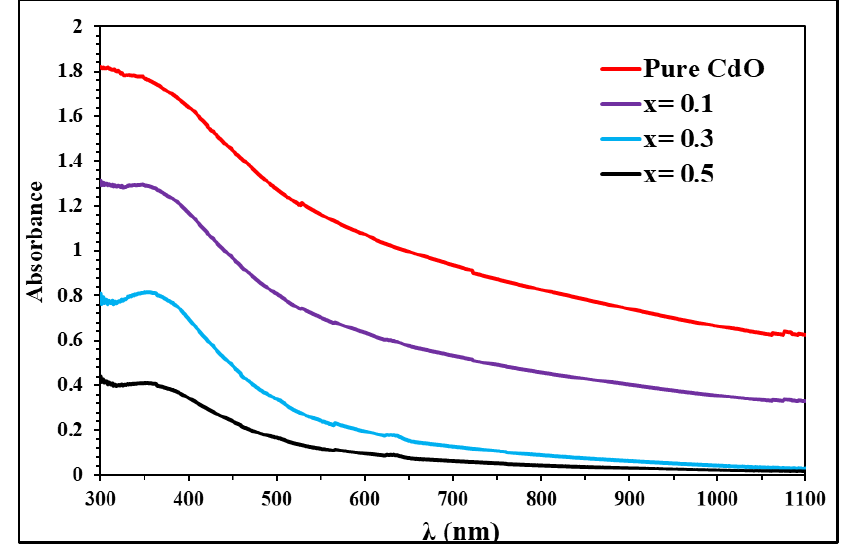
Figure 4: Variation of absorption with wavelength for (CdO)